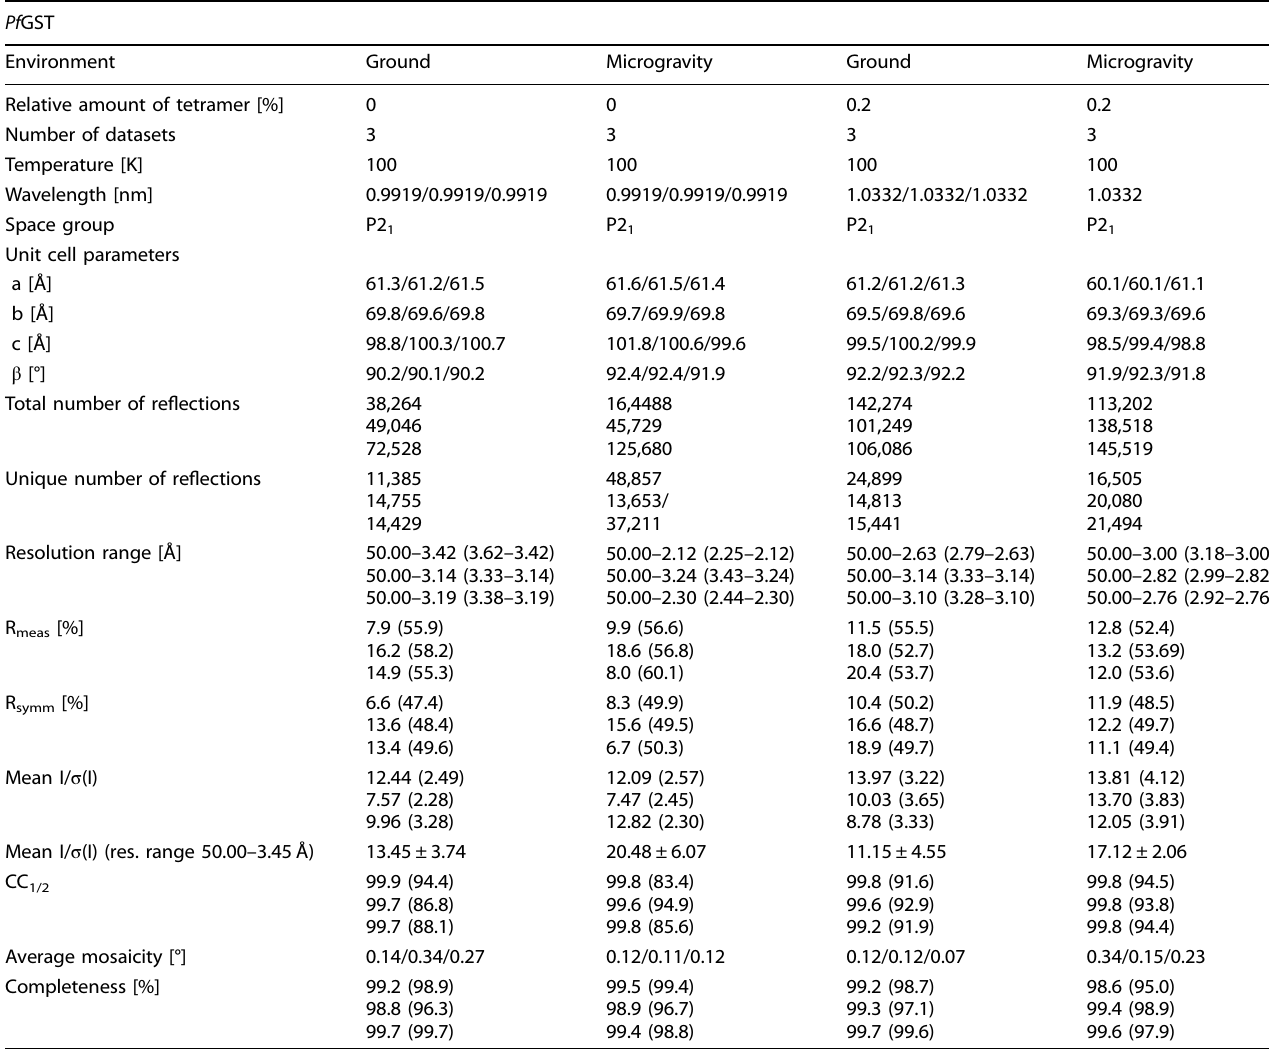
Table 1. Comparative summary and statistics of Pf GST X-ray diffraction data with 0 and 0.2% fl uorescence labeled tetramer applied as impurity during the crystallization experiments